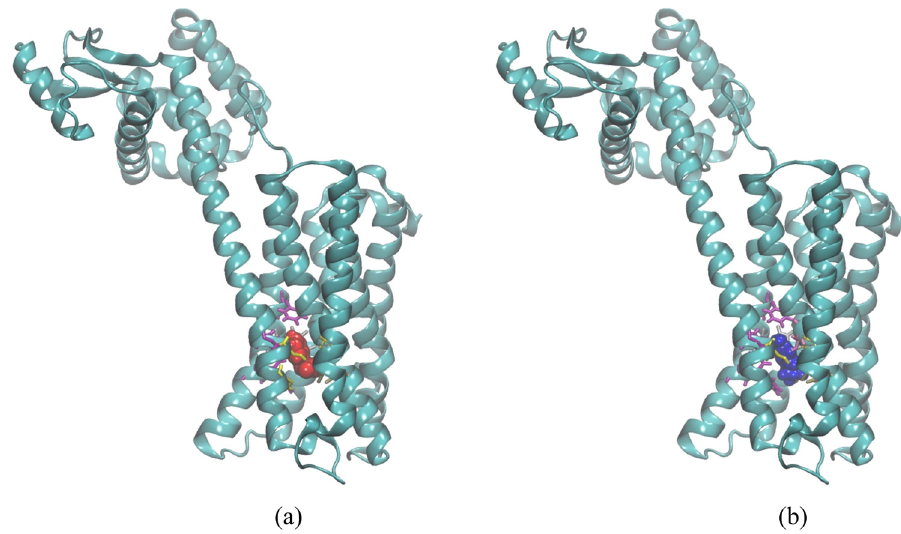
Figure 3: Binding poses for styrene oxide ( a ) and dopamine ( b ) on the DrD2